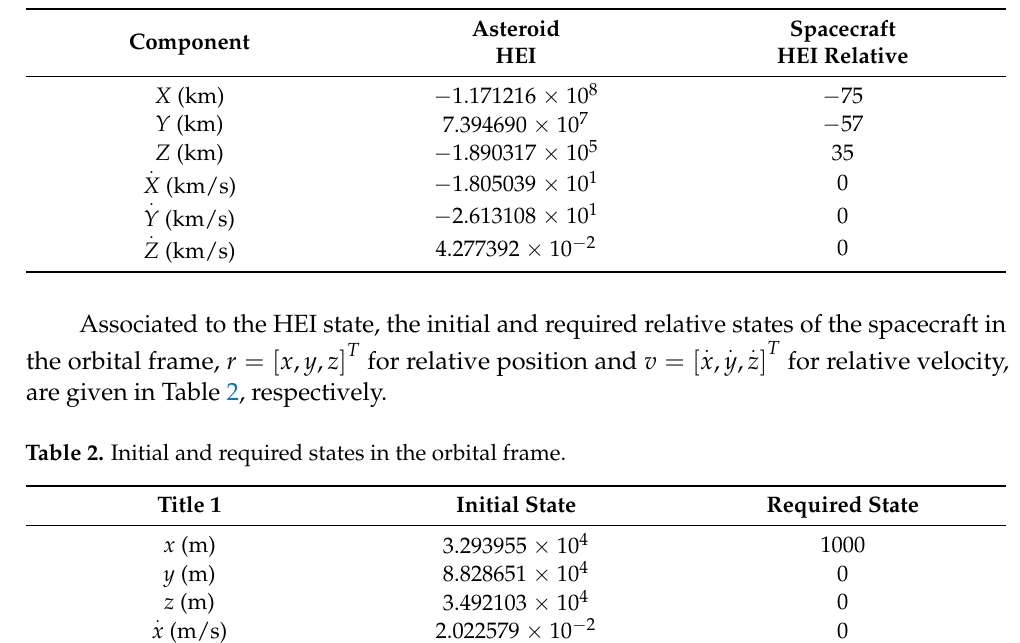
Table 1. Initial states in the heliocentric ecliptic inertial (HEI) frame.